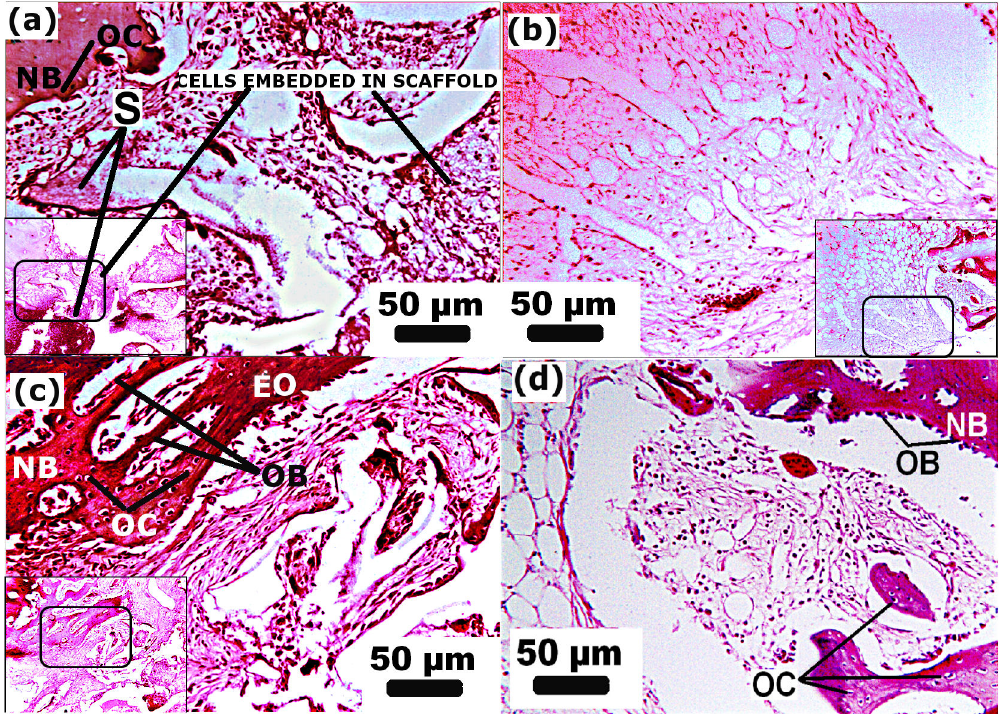
Figure 7. Histology illustrating hematoxylin and eosin (H&E) stained section after week 01 and 02 after implantations of n- HA/gel/CMC (a, c) and of SHAM treated site (b, d) respectively. S: scaffold, NB: new bone, OB: osteoblast, OC: osteocyte. EO: endochondral ossification. Scale Bar: 50µm (magnification=125X, inset magnification=50X). doi: